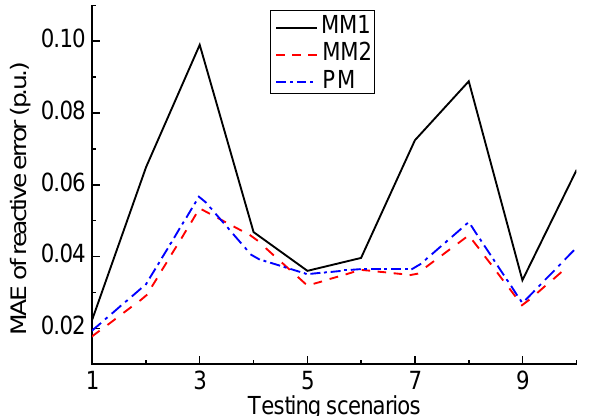
Figure 8. Reactive power errors of different models in quasi-steady-state process during fault dura- tion.